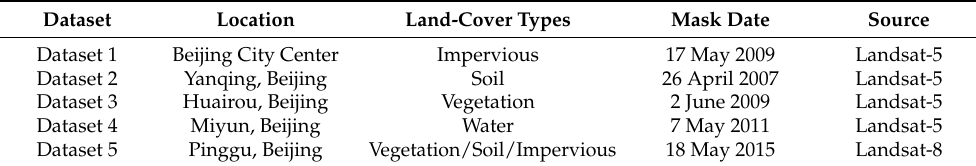
Table 2. Information on five